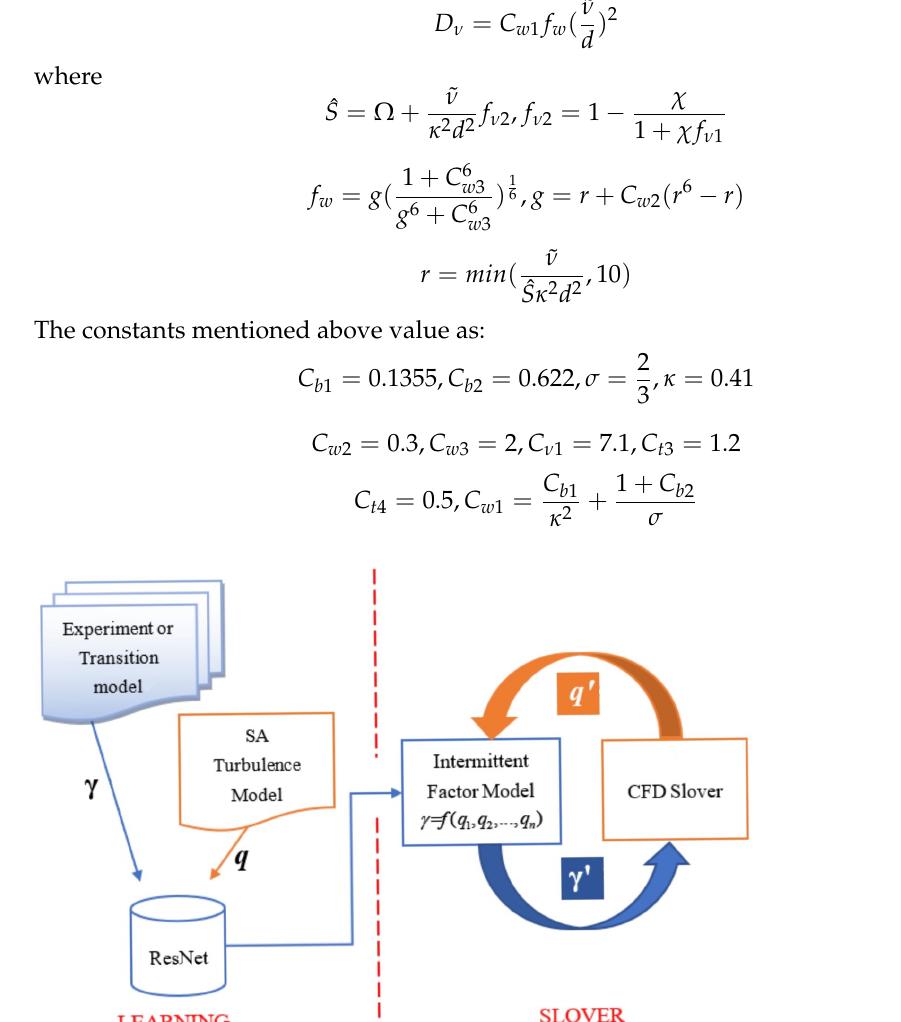
Figure 1. Main framework of coupling